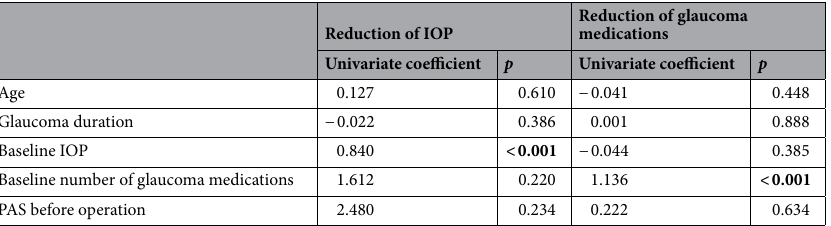
Table 5. Univariate regression analysis for factors correlated with the reduction of IOP (R 2 = 0.649) and reduction of the number of glaucoma medications (R 2 = 0.832). Bold values demonstrated the significance of the difference IOP intraocular pressure, PAS peripheral anterior